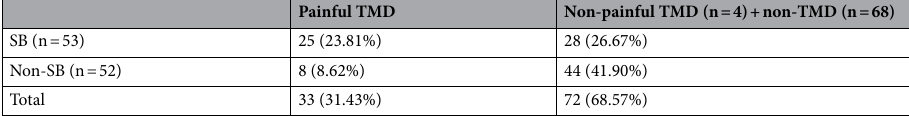
Table 2. Frequency distribution of painful TMD ( n = 105). SB sleep bruxism, TMD temporomandibular disorder, df degrees of